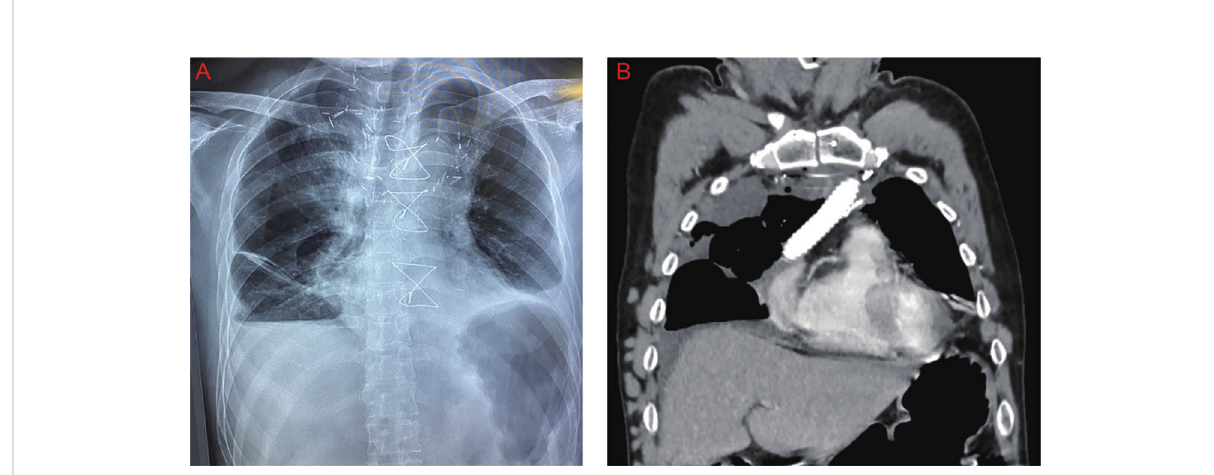
FIGURE 3 Postoperative X-ray (A) and computed tomography (B) imaging of the